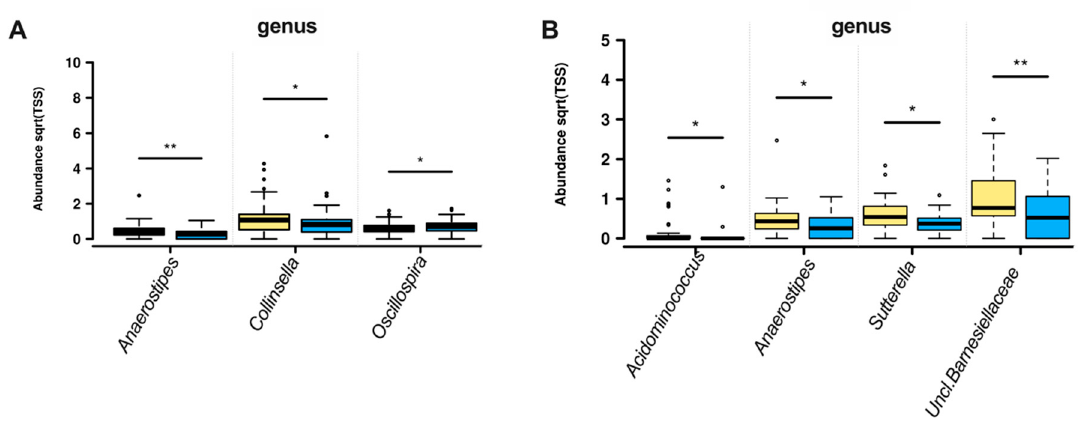
Figure 3. Comparison of genera abundance at 28 weeks gestation in women with lower and higher fiber intake who remain normotensive. ( A ) Genus abundance with fiber intake below (lower fiber; yellow boxes) or above (higher fiber; blue boxes) the median (18.2 g / day). ( B ) Genus abundance with fiber intake in the lowest (Q1; < 13.9 g / day; yellow boxes) and highest (Q4; > 23.1 g / day; blue boxes) of fiber intake. * = p < 0.05, ** = p < 0.01.